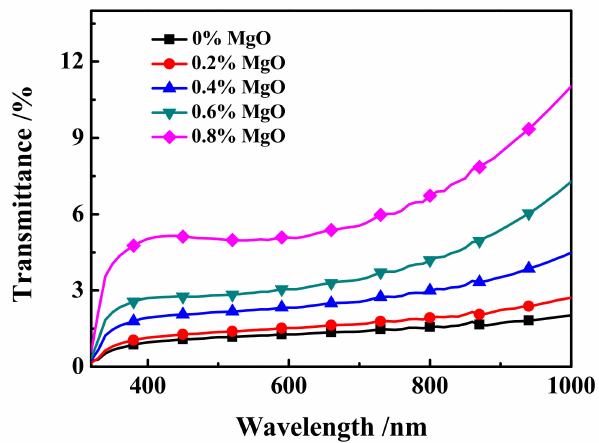
Figure 9. The off-state transmittance (T off )-wavelength ( λ ) curve of samples c1~c5.